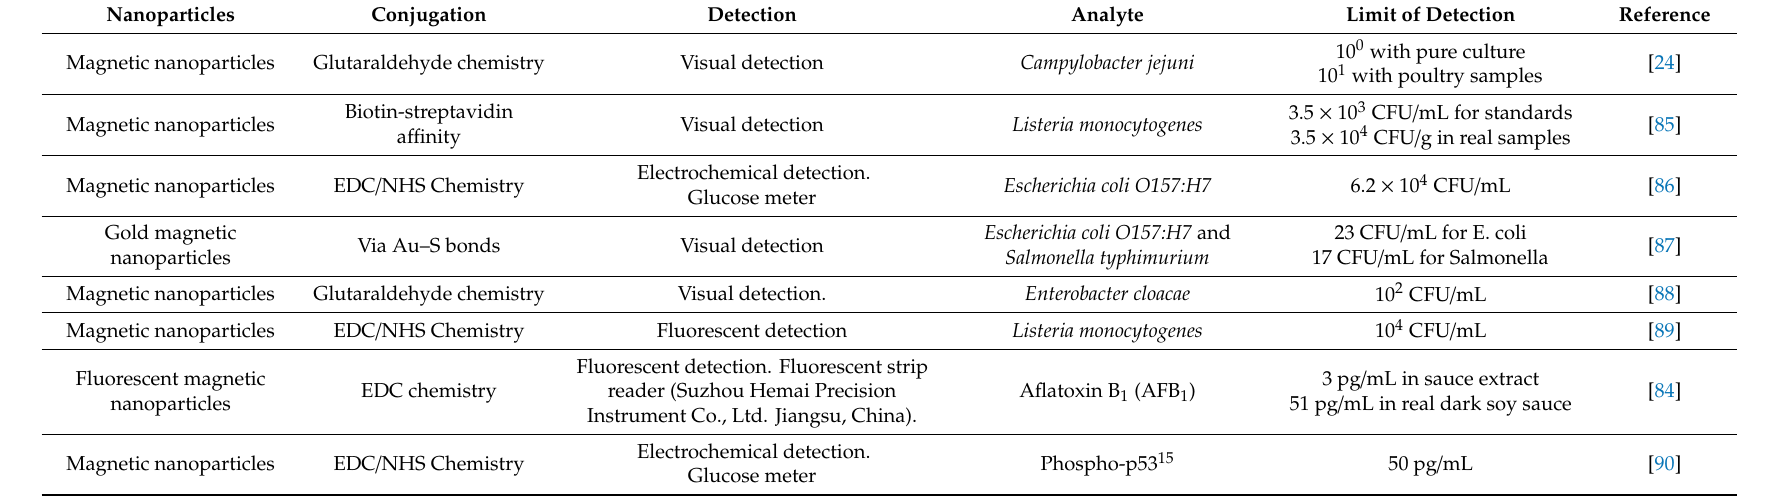
Table 5. Other detection and magnetic nanoparticles used for immunomagnetic